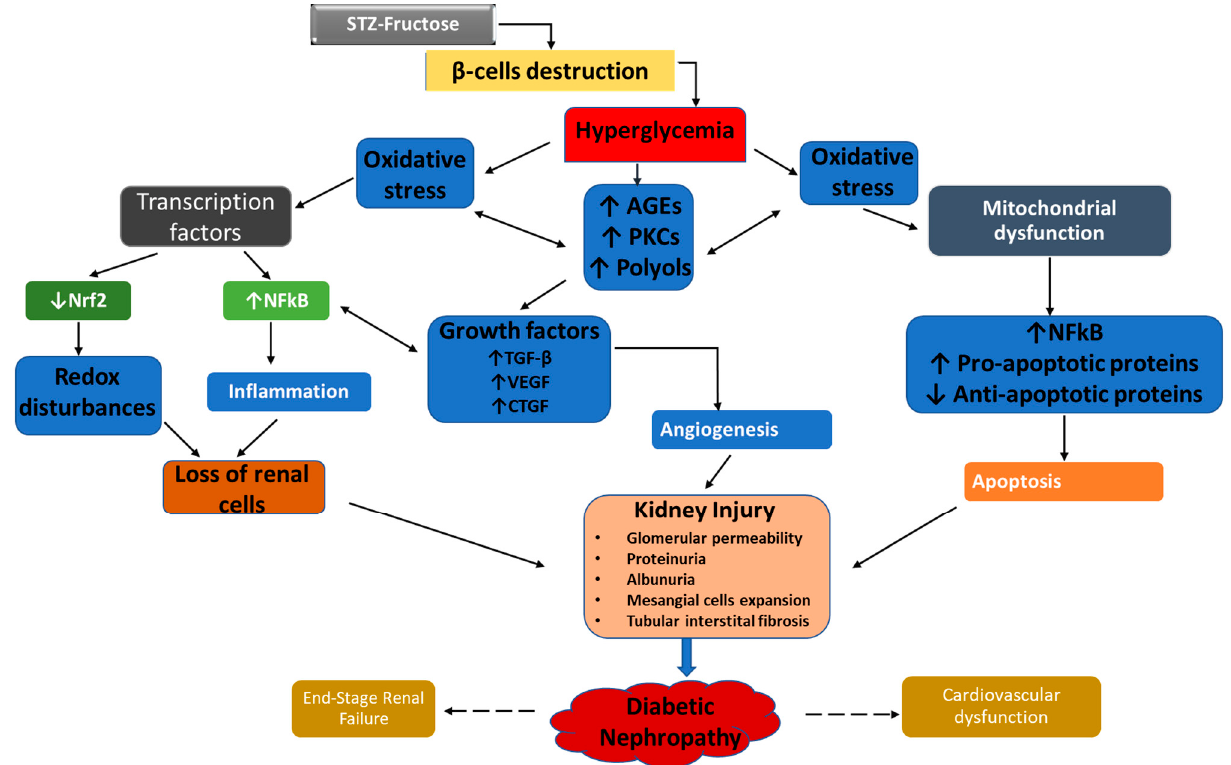
Figure 1. Pathogenesis of diabetic nephropathy.